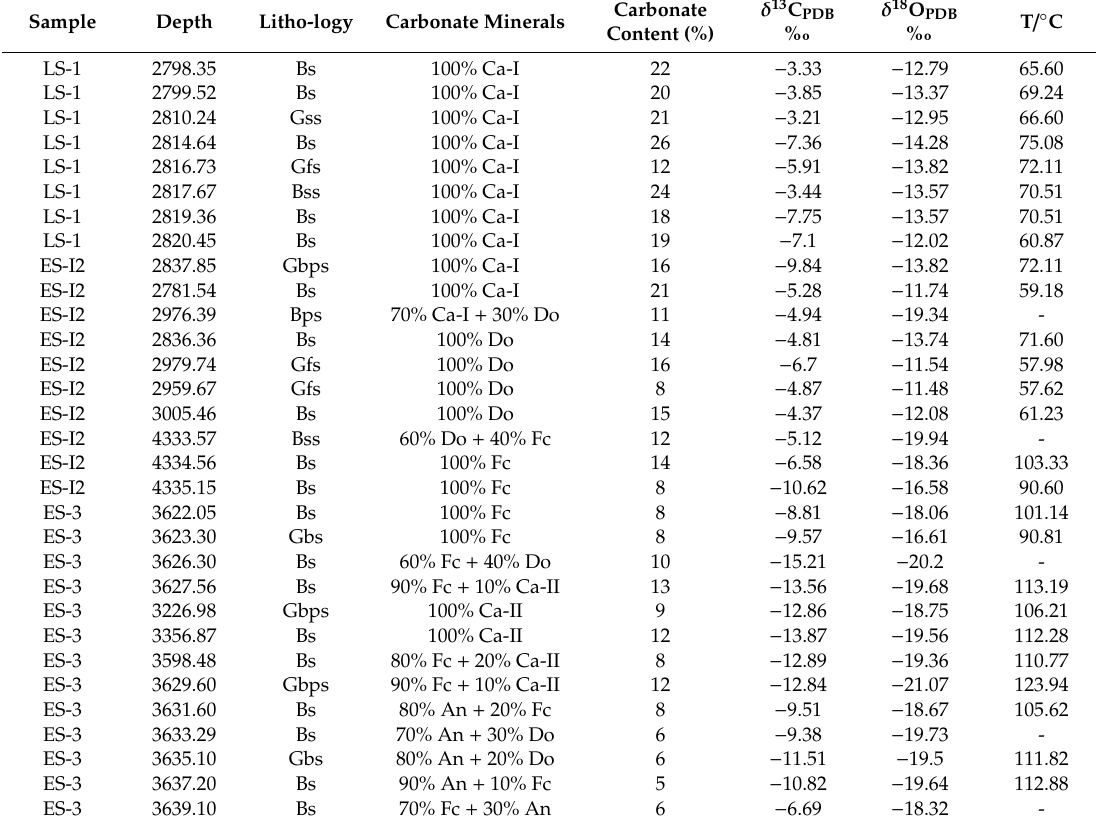
Figure 12. ( a ) Scatter diagram of δ 13 C and δ 18 O for calcite cements in the Lulehe sandstone reservoirs. The δ 13 C values indicate that sparry carbonate cements were influenced by organic matter (the model modified after Rahman [37]). ( b ) Ternary plot of Fe–Mg–Mn element compositions of carbonate cements, data from Table 1. Table 2. Mineralogical and carbon and oxygen isotopic composition of carbonate cements, and calculated formation temperature of carbonate cements in Lulehe sandstone.